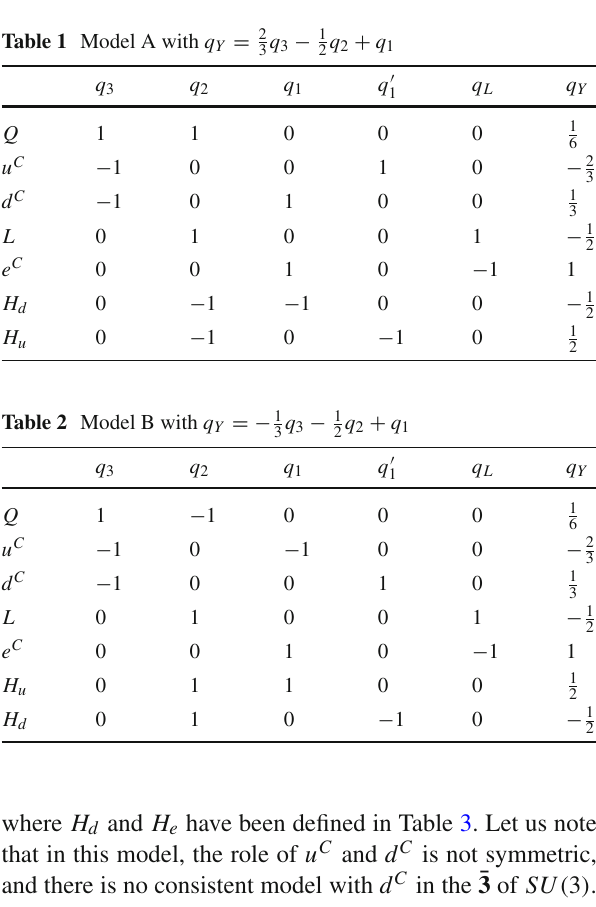
with T Grav = 1 for the gravitational anomalies. One gets, for